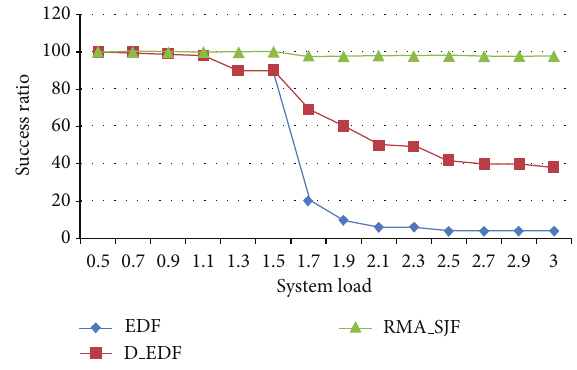
Figure 12: Success ratio analyzed with EDF, D EDF, and RMA-SJF.